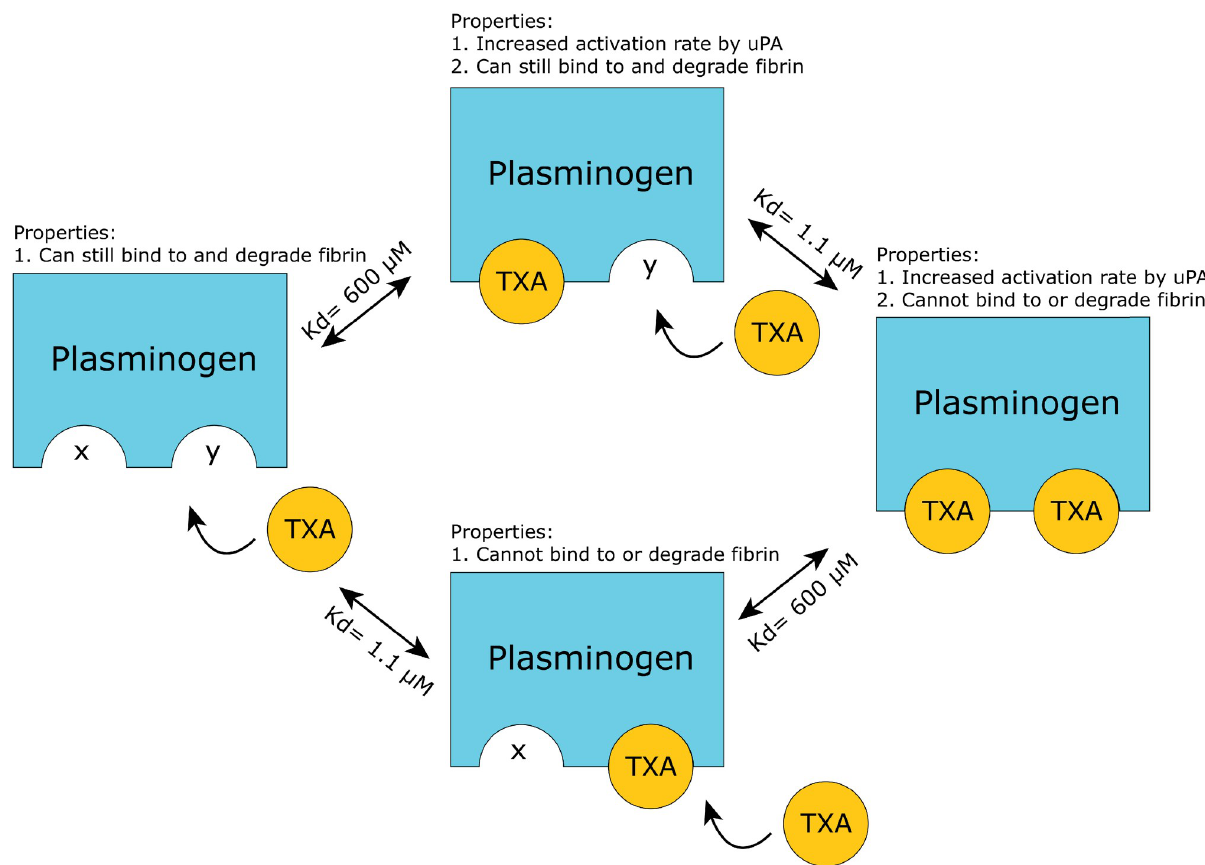
Fig 3. Diagram of different variants of TXA-bound plasminogen. Plasminogen has 2 binding sites that interact with TXA (labeled x and y in the model). One of the binding sites with K = 600 μ M changes the conformation that speeds up activation by uPA. The other binding site with K d prevents binding to fibrin, which prevents activation via tPA as well as fibrin degradation. UPA can activate all 4 of these variants, whereas tPA can activate only the variants with the second binding site free.